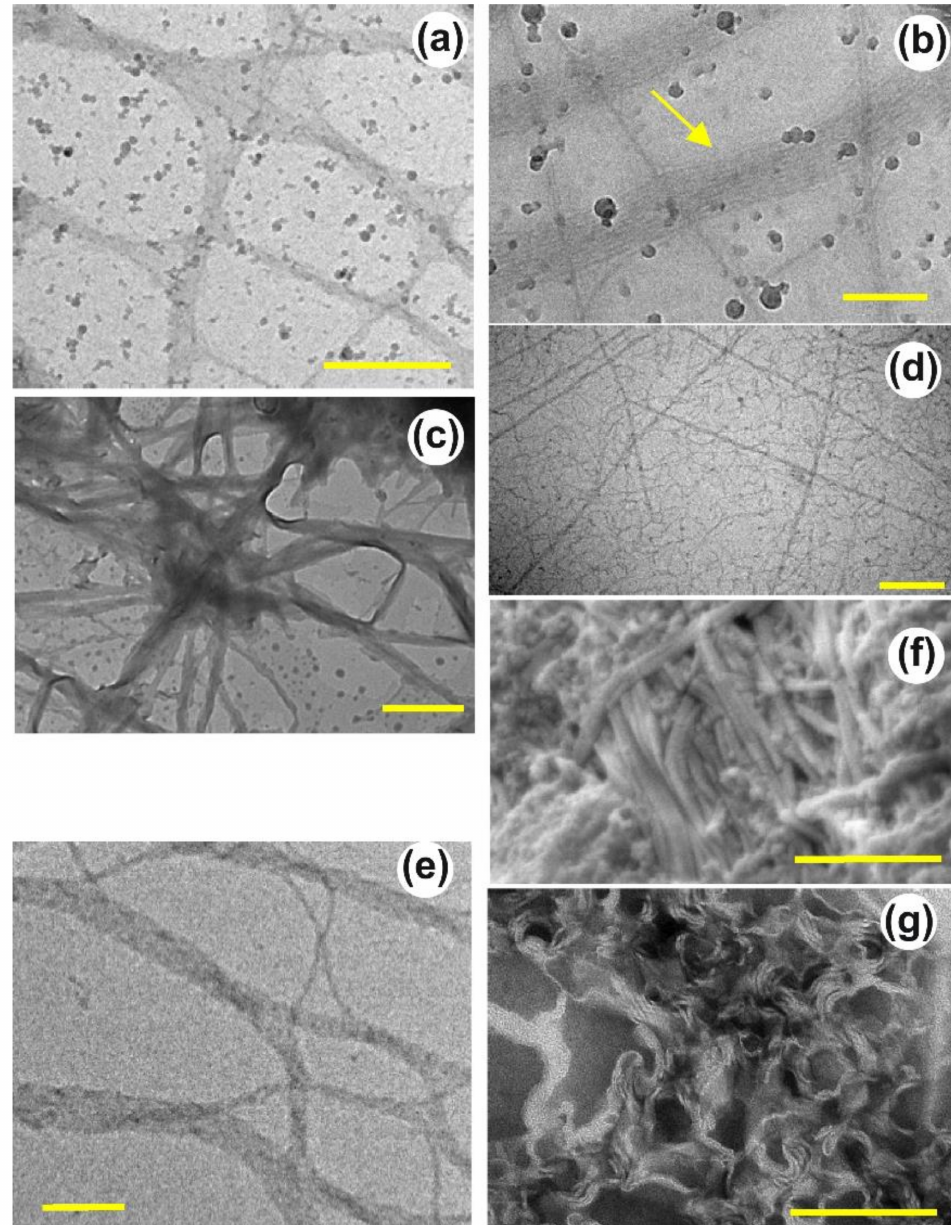
Figure 6. The morphologies of hydrogels formed from relatively concentrated solutions of a low- molecular-weight sugar-based hydrogelator with ( a–c ) showing ribbons and sheets, ( d ) showing micelles, and ( e–g ) showing helical fibers. ( a , b , d , e ) were acquired from cryogenic transmission electron microscopy (cryo-TEM), ( c , g ) from transmission electron microscopy (TEM), and ( f ) from cryogenic scanning electron microscopy (cryo-SEM). The bar indicates 200 nm in ( b , d , e , g ), 500 nm in ( a , f ), and 1 mm in ( c ). Reproduced with permission from [18] ©2017,